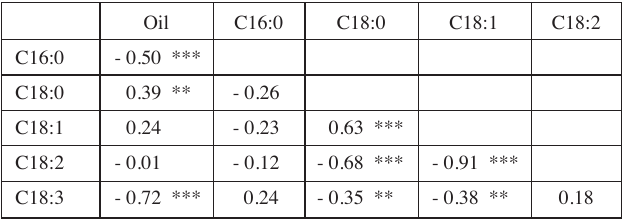
Tab. 3: Correlations between oil content and FAs of L. angustifolius geno- types